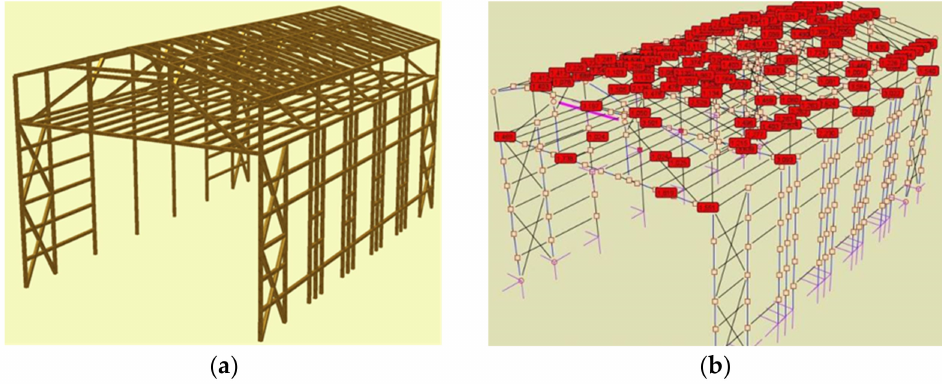
Figure 17. Skeletal structure model of the main segment ( a ), and elements with exceeded bearing capacity ( b ).